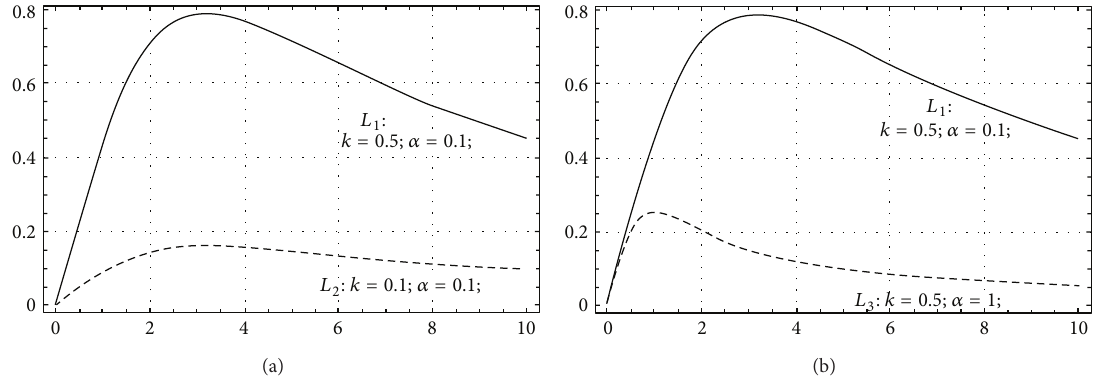
Figure 1: Nonmonotone incidence function 𝑔(𝑦)